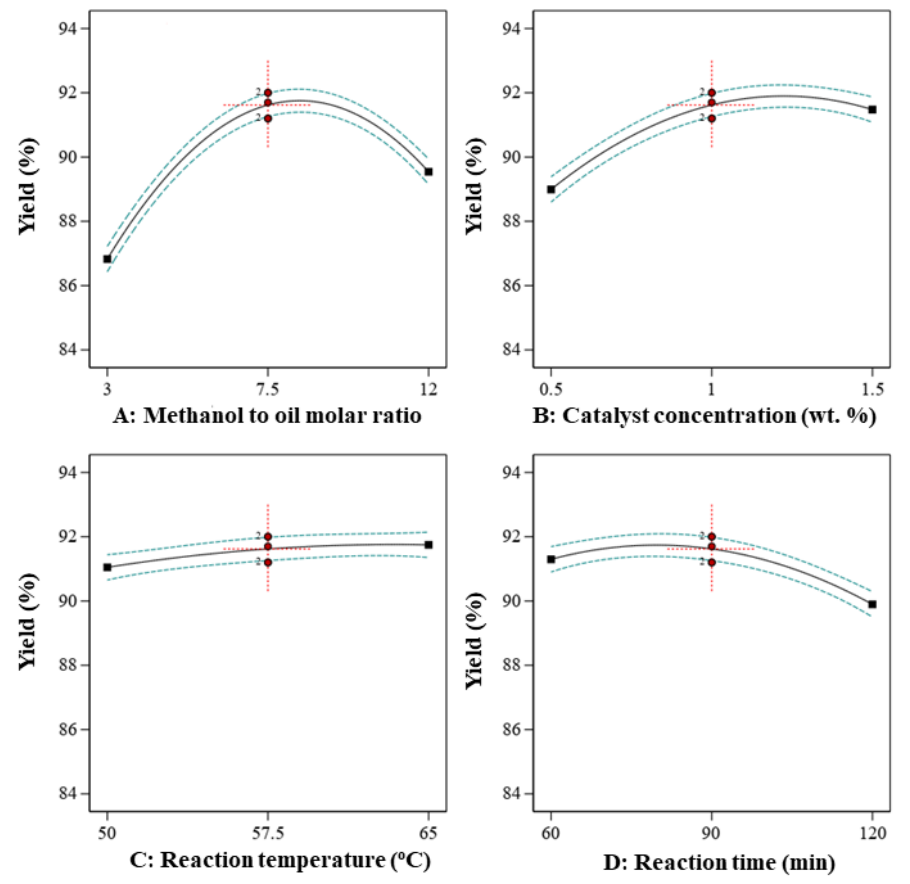
Figure 3. Main effect plot for biodiesel yield.